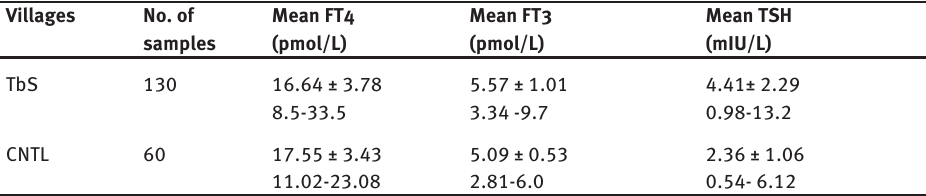
Table 2: FT4, FT3 and TSH Concentration in Serum of Subjects of the two Villages. Villages No. of